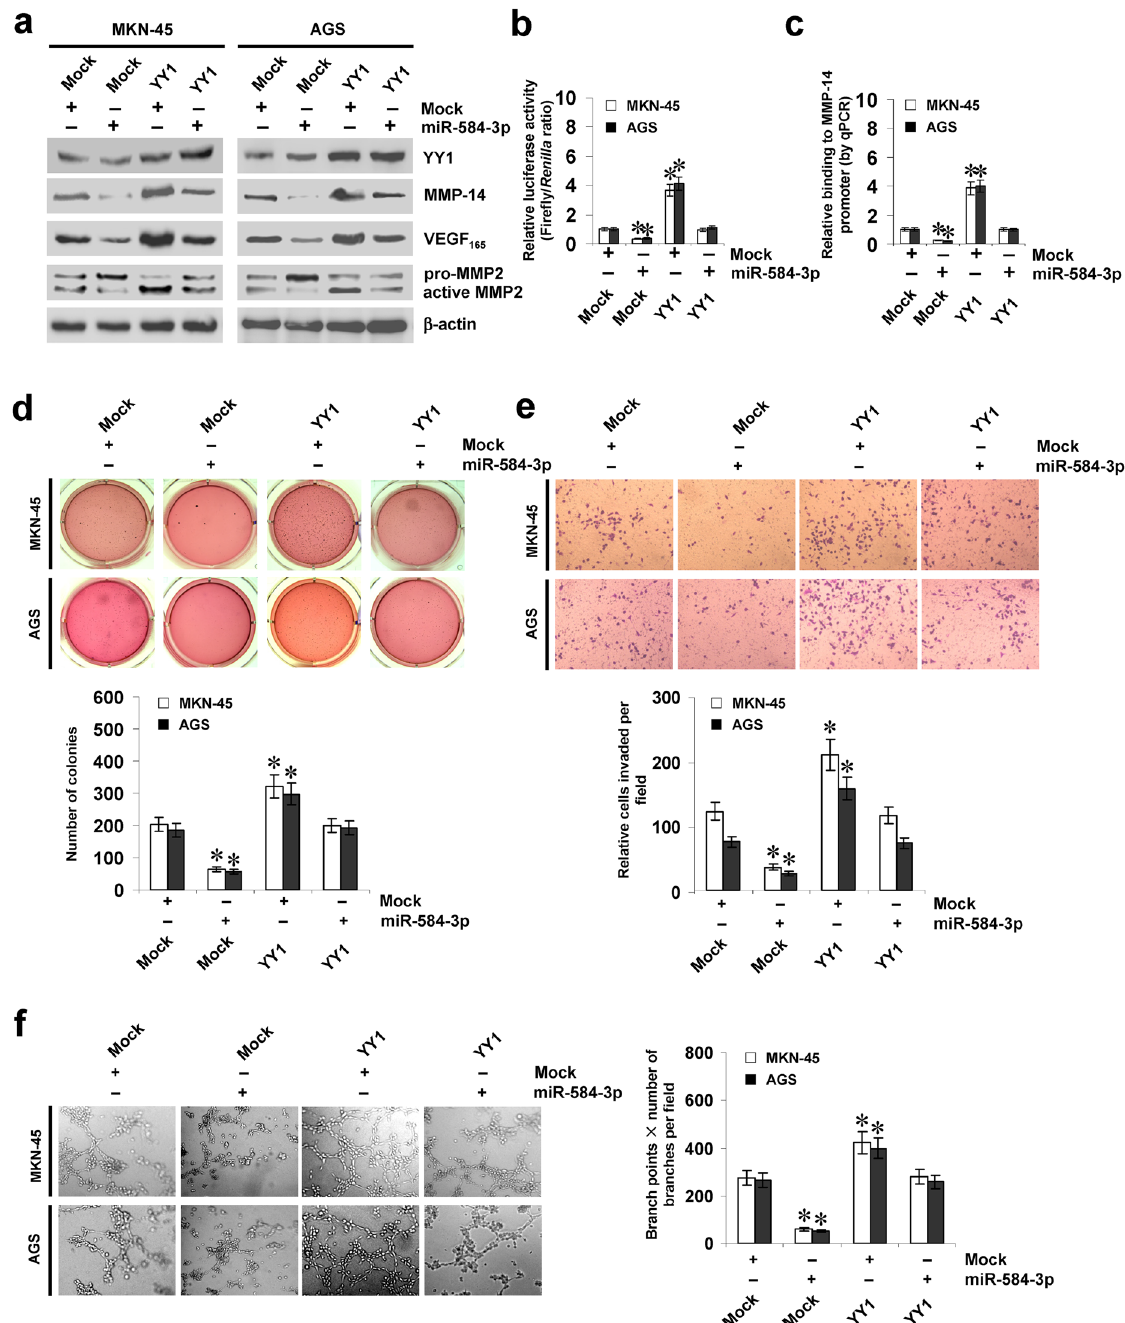
Figure 4. miR-584-3p suppresses the tumorigenesis and aggressiveness of gastric cancer cells via repressing YY1-facilitated MMP-14 expression in vitro . ( a and b ) Western blot and dual-luciferase assays showing the expression of YY1, MMP-14, VEGF 165 , and MMP-2 and activity of MMP-14 promoter reporter [pGL3- MMP14 (-1246/ + 199)] in MKN-45 and AGS cells stably transfected with empty vector (mock) or miR-584-3p precursor, and those co-transfected with YY1 (mean ± SD, n = 4). ( c ) ChIP (using YY1 antibody) and qPCR assay indicating the enrichment of YY1 on MMP-14 promoter in gastric cancer cells stably transfected with mock or miR-584-3p precursor, and those co-transfected with YY1 (mean ± SD, n = 4). ( d ) Representation (top) and quantification (bottom) of soft agar assay showing the anchorage-independent growth of MKN-45 and AGS cells stably transfected with mock or miR-584-3p precursor, and those co-transfected with YY1 (mean ± SD, n = 5). ( e ) Representation (top) and quantification (bottom) of matrigel invasion assay indicating the invasion capability of gastric cancer cells stably transfected with mock or miR-584-3p precursor, and those co-transfected with YY1 (mean ± SD, n = 5). ( f ) Representation (top) and quantification (bottom) of tube formation assay showing the angiogenic capability of gastric cancer cells stably transfected with mock or miR-584-3p precursor, and those co-transfected with YY1 (mean ± SD, n = 5). * P < 0.01 vs. mock +